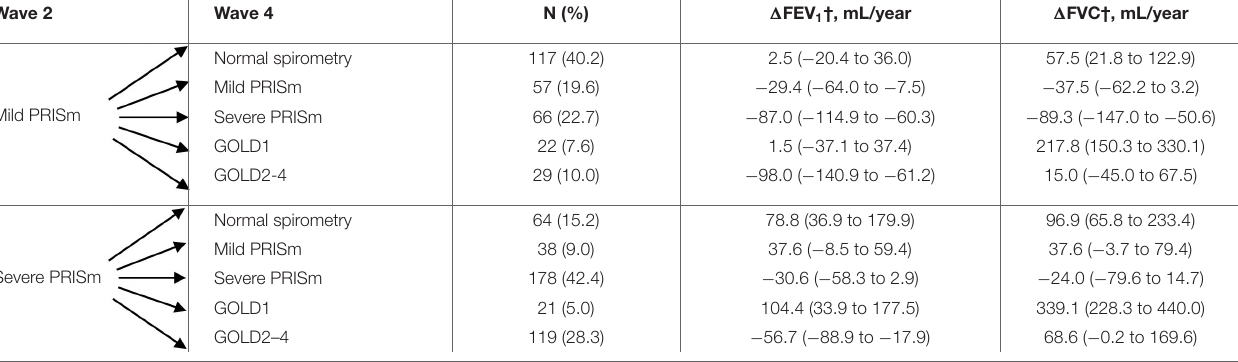
TABLE 3 | Changes of lung function categories, FEV 1 , and FVC among subjects with mild PRISm and severe PRISm from Wave 2 to Wave 4. Wave